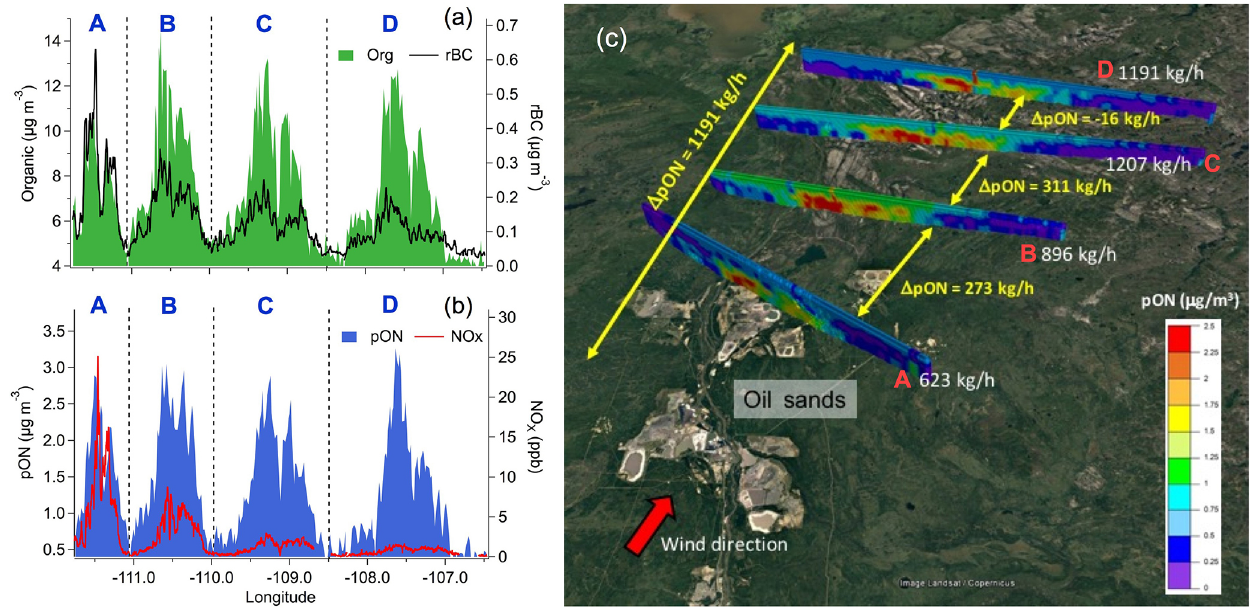
Figure 2. Aircraft observations: (a) organic aerosol and rBC and (b) pON and NO x concentrations measured at the four screens (A to D) shown in (c) . Organic aerosol and pON concentrations remained roughly constant during dispersion, whereas rBC and NO x decreased continuously. (c) Results from the TERRA algorithm, which estimate a total pON production of 1.2th − 1 (or 15.5td − 1 ) downstream of oil sands operations (i.e. the sum of (cid:49) pON between the four screens – A to D), constrained by the aircraft